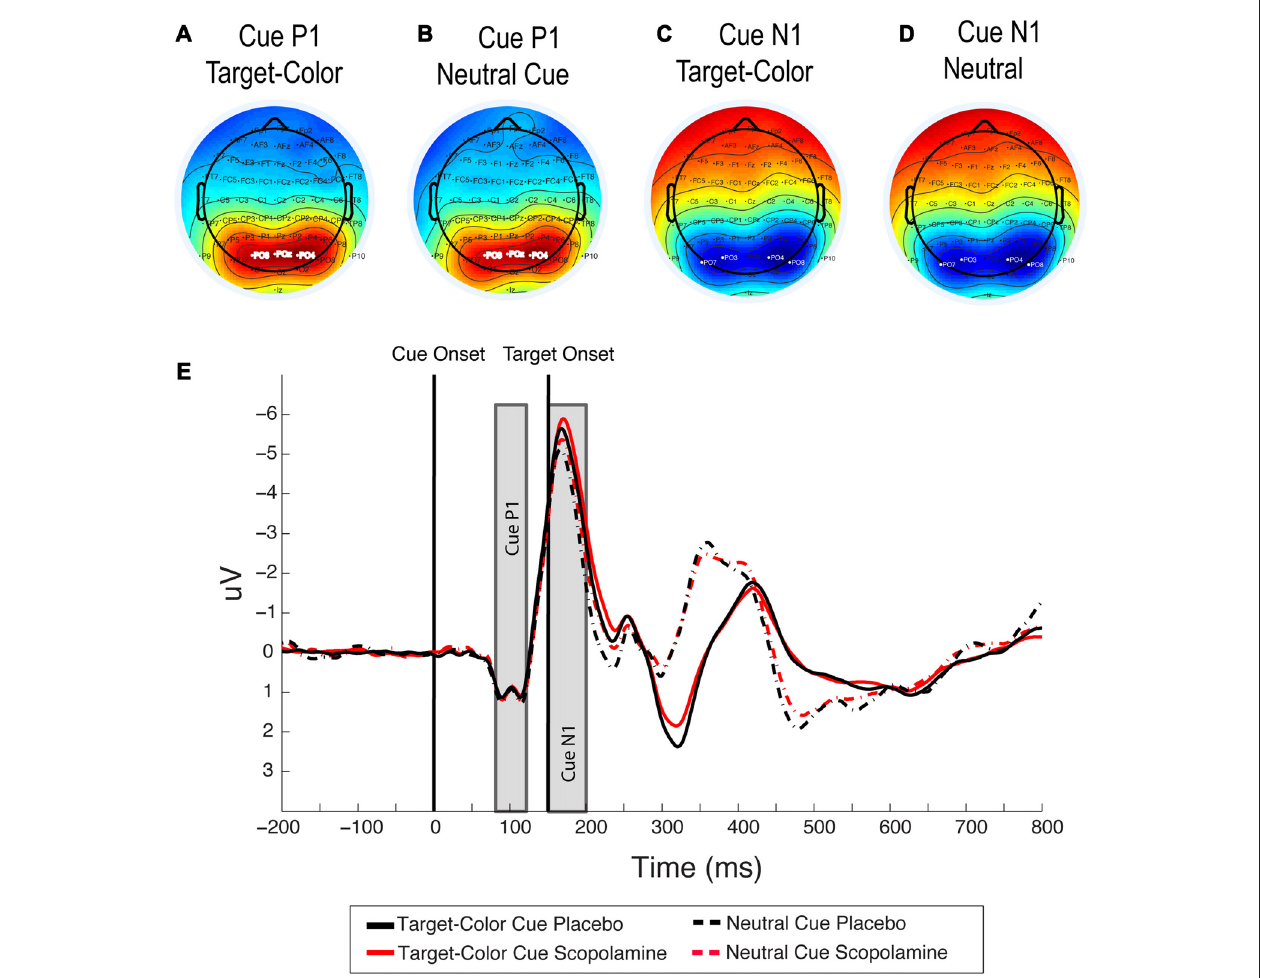
FIGURE 4 | (A,B) Topography of the cue-related P1 component under placebo for target-colored cues and neutral cues averaged between 80 ms and 120 ms after cue onset. (C,D) Topography of the cue-related N1 component under placebo for target-colored cues and neutral cues, averaged between 150 ms and 200 ms after cue onset. (E) Grand-average waveforms illustrating cue related P1 and N1 components for neutral and target-colored cues, under placebo and scopolamine, averaged over PO3, PO4 and POz electrodes for the P1 component and over PO7, PO3, PO8 and PO4 electrodes for the N1 component; n =